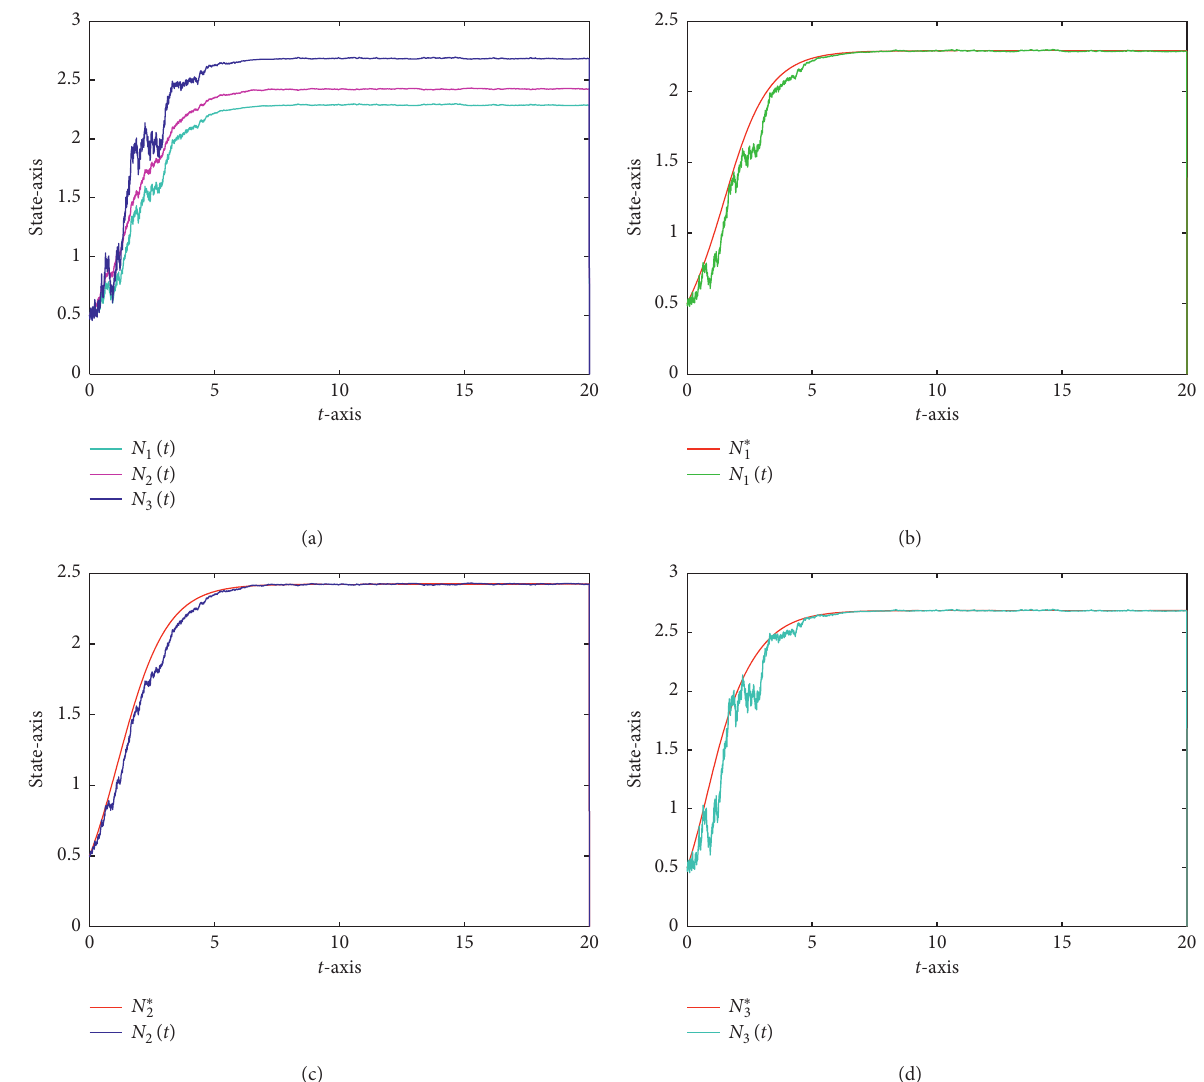
Figure 4: Stable case of system (6) with σ state graphs of the populations N